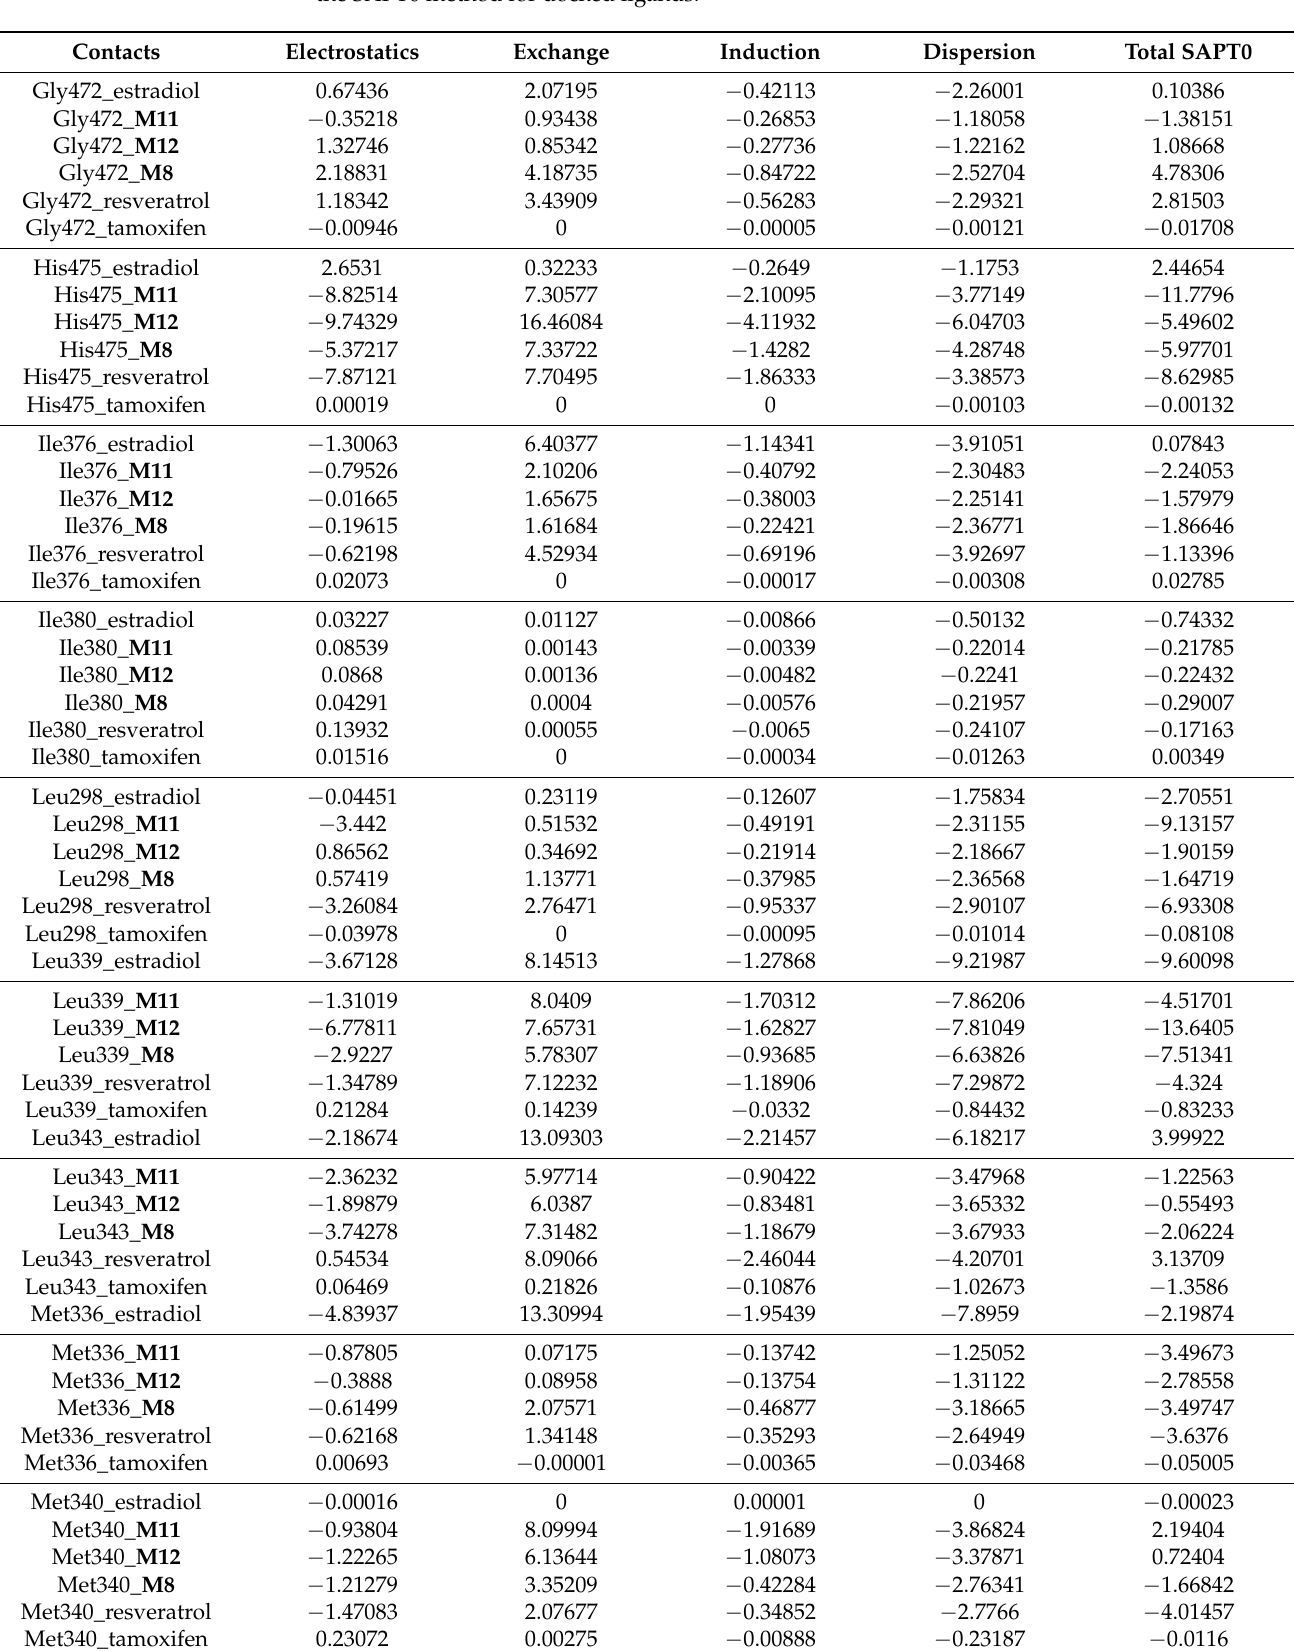
Table 4. ER β Calculated total values of the interaction ligand amino acid energy (kcal/mol) using the SAPT0 method for docked